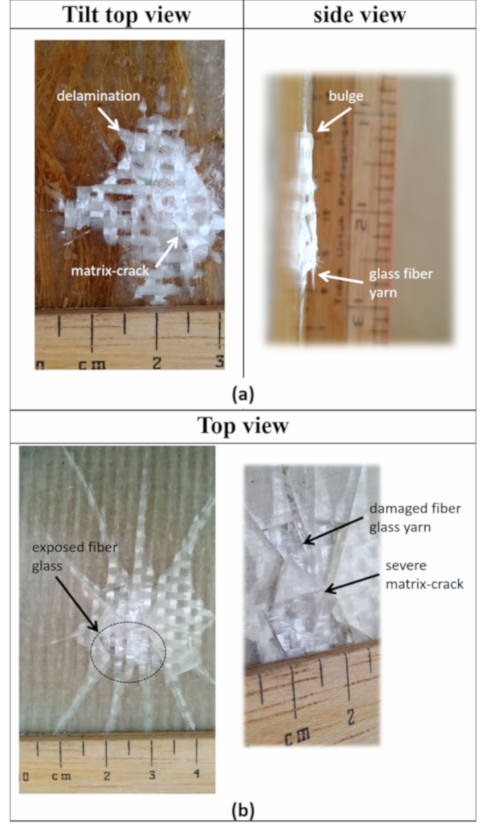
Figure 16. Close-up view of impacted composites: ( a ) GPG 9.0 J, ( b ) GGGG 12.0